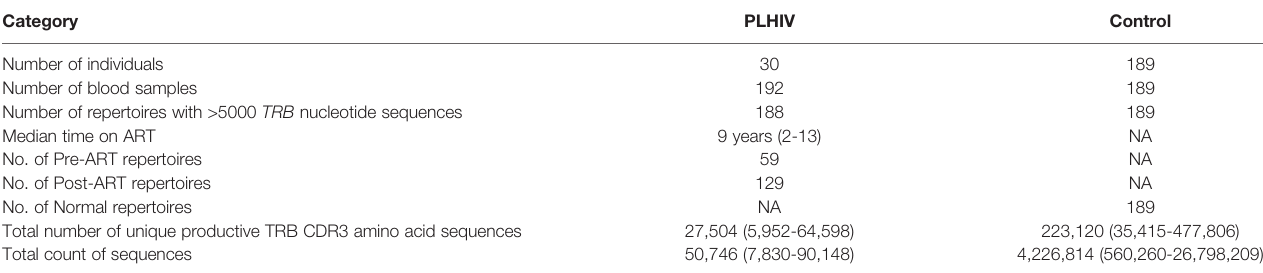
TABLE 1 | Characteristics of the PLHIV and control cohorts and sample sets, with mean and range of the total number of unique productive TRB CDR3 amino acid sequences and total number of TRB nucleotide sequences in the repertoires in each